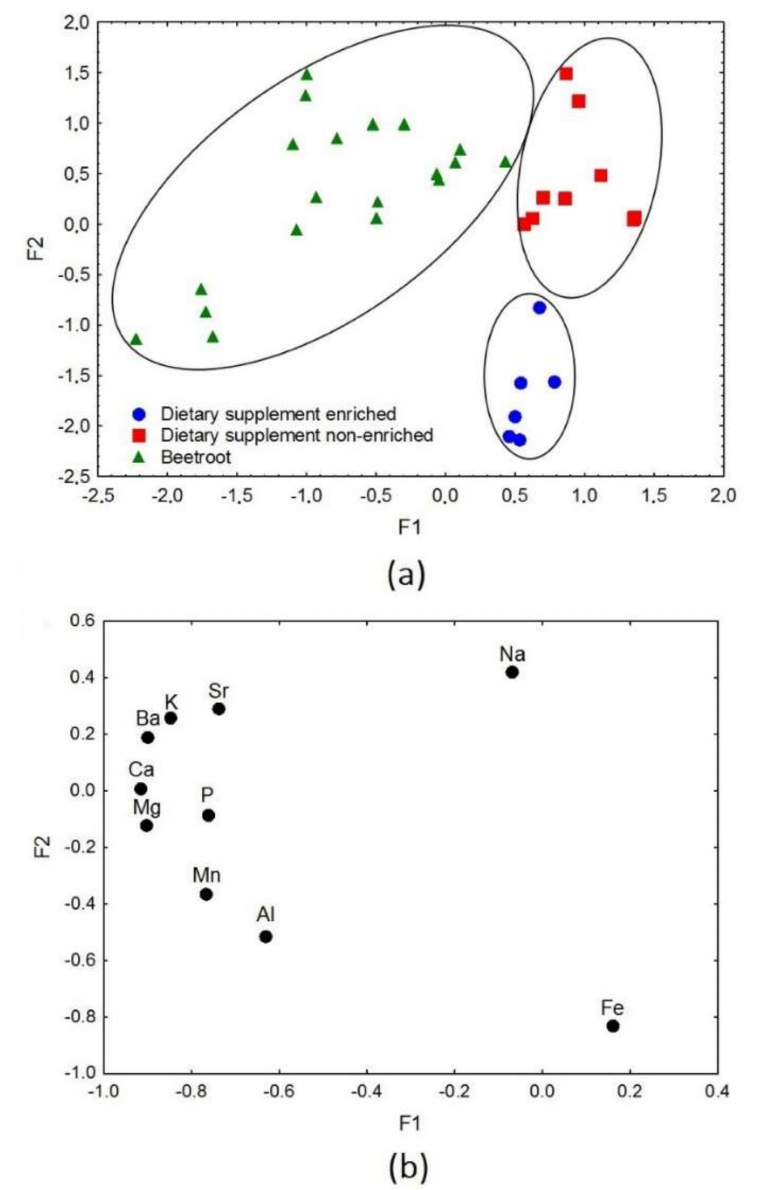
Figure 4. ( a ) Scatter plot of object samples of two factors for the dataset of beetroots and all dietary supplements. ( b ) Scatter plot of loading for elements in all the analysed